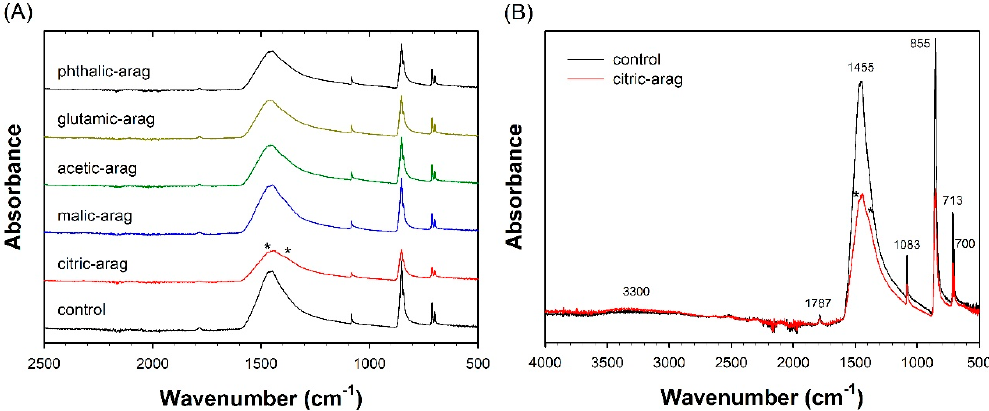
Figure 7. ( A ) Fourier transform-infrared (FT-IR) spectra of the co-precipitated aragonite samples. ( B ) Comparison of the control and the citric-arag samples. Weak feature (*) is described in the text.